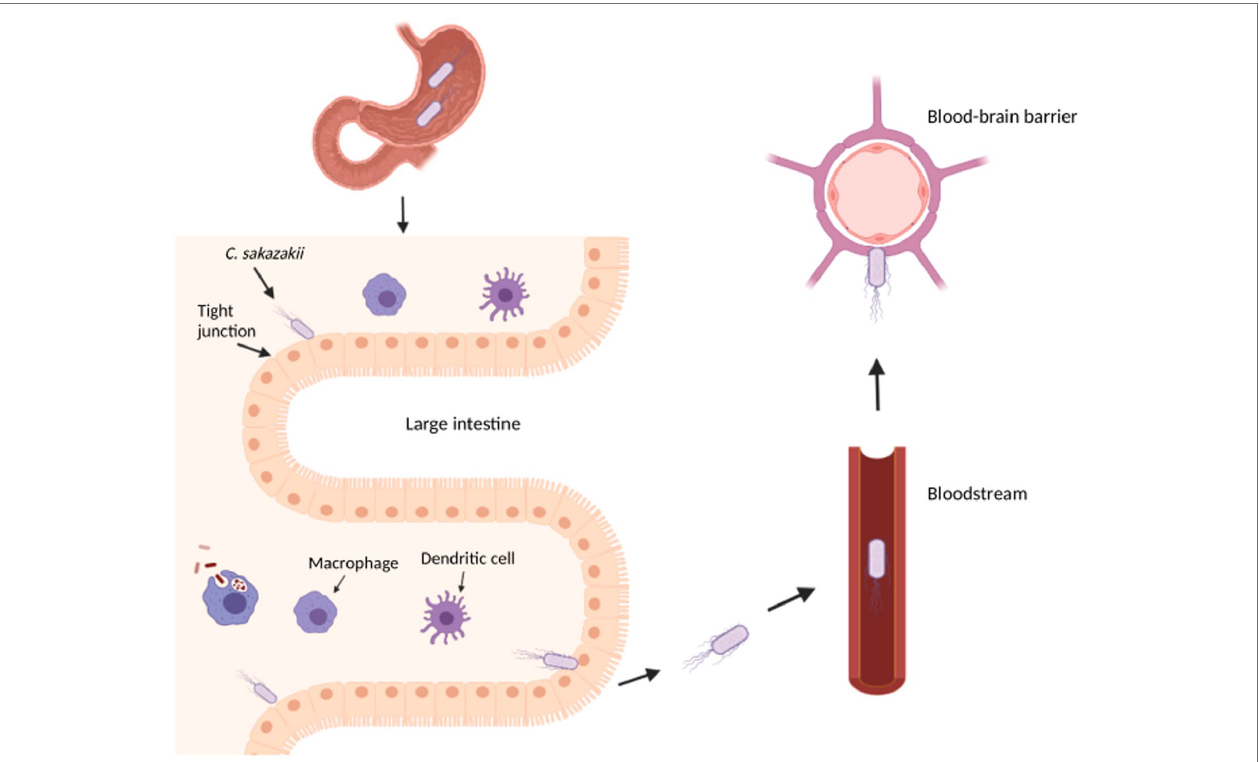
FIGURE 1 | Overview of Cronobacter sakazakii pathogenesis in an infant. This diagram illustrates the transit of C. sakazakii through the stomach and small intestine to reach the large intestine. In the large intestine, C. sakazakii can evade the immune cells to disrupt the epithelial layer, potentially causing necrotizing enterocolitis and entering the bloodstream to cause sepsis. From the bloodstream, C. sakazakii can enter the blood–brain barrier to cause meningitis. The image was created with